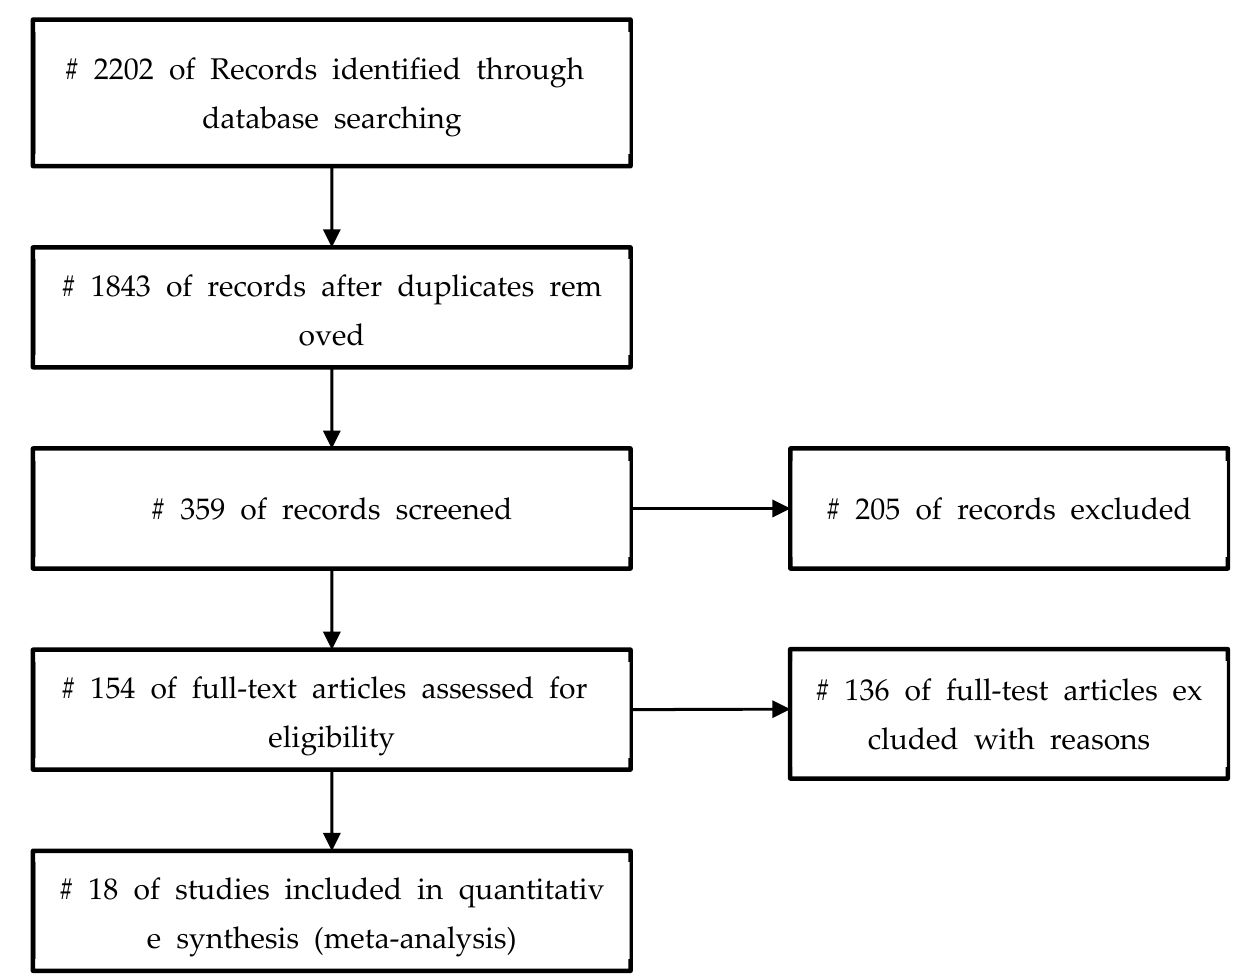
Figure 1. PRISMA flow diagram of the included study.